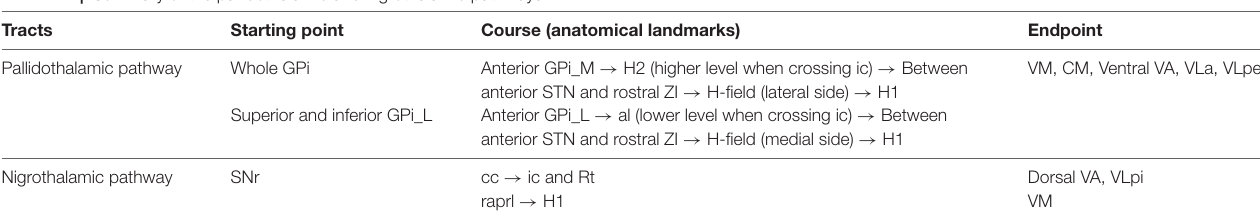
TABLE 1 | Summary of the pallidothalamic and nigrothalamic